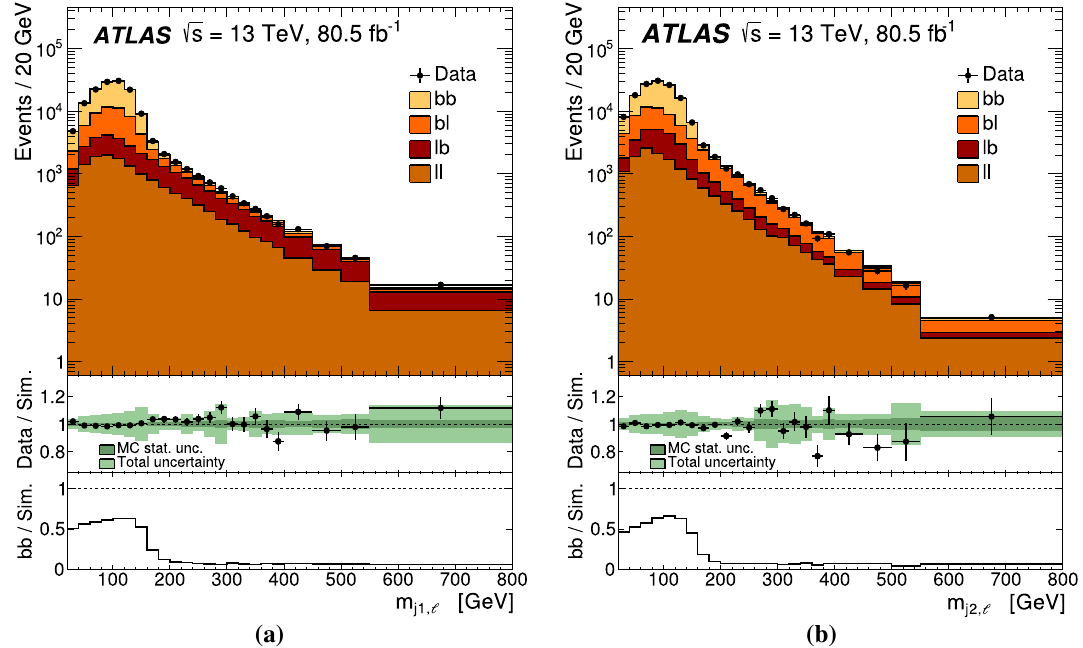
Fig. 5 Distribution of the (a) m j 1 ,(cid:14) and (b) m j 2 ,(cid:14) observables in events passing the selection. Simulated events are classified in terms of the flavour composition of the two jets. The ratio panels show the data-to-simulation ratio as well as the fraction of bb events among the simulated events